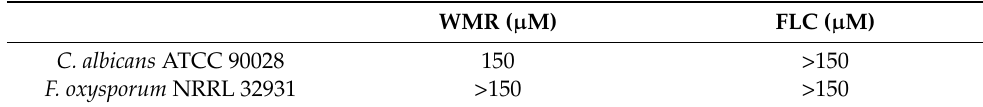
Table 1. Susceptibility of the two fungal species to WMR and